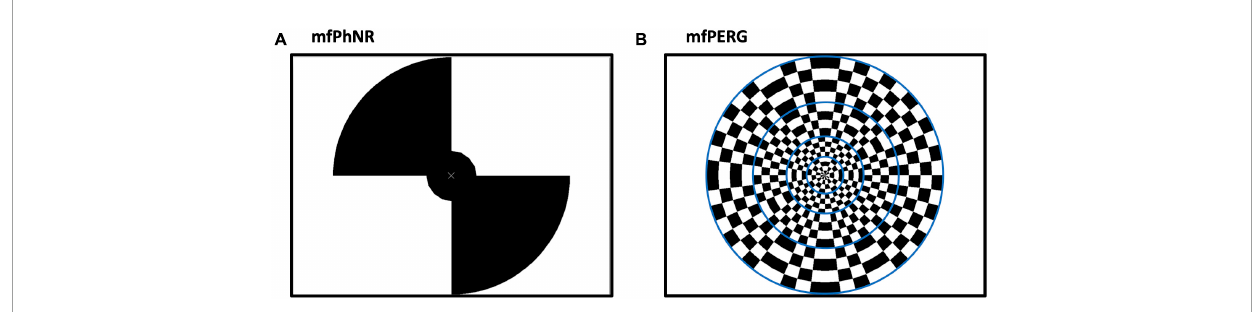
FIGURE1 (A) Multifocal electroretinogram to record photopic negative response (mfERG PhNR ) stimulus spanning two eccentricities with five stimulated fields (snap shot with two peripheral locations “on”, and two plus the central “off”). (B) Multifocal pattern electroretinogram (mfPERG) spanning four eccentricities with a total of 36 stimulated fields. Blue lines are not seen by the patient but to graphically delineate different eccentricities.